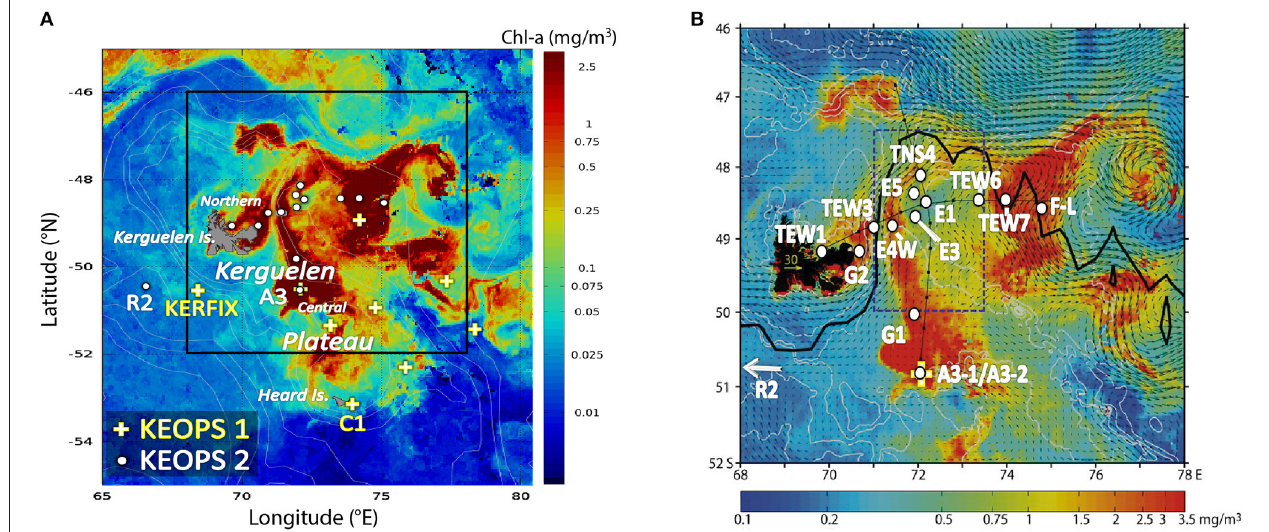
FIGURE 1 | (A) Location of the REE samples collected during KEOPS1 (yellow crosses and upper case names; Central Kerguelen Plateau area) and KEOPS2 cruises (white dots and upper case names; Northern Kerguelen Plateau area), in the Indian sector of the Southern Ocean. White italic names refer to topographical features. (B) Zoom on the KEOPS2 area [defined in (A) by the black square], which details the station names. The stations are superimposed on the composite chlorophyll-a surface concentration map, derived from chlorophyll satellite images from 19 October to 19 November 2011, overlaid in (B) by the mean surface velocity field over the same period (arrows, scale shown in yellow on the Kerguelen Islands) and the hydrography-derived climatological Polar Front (thick black line), by courtesy of Young-Hyang Park and co-authors (Figure 6 of Park et al., 2014, reproduced with